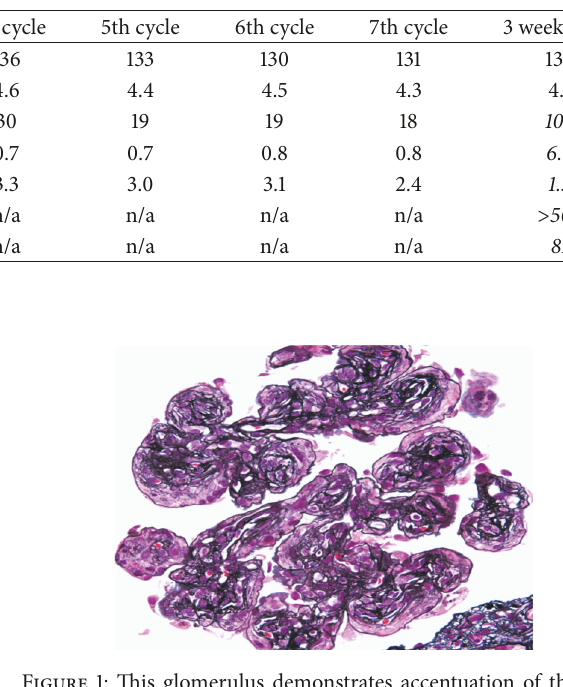
Figure 1: This glomerulus demonstrates accentuation of the lob- ular architecture with associated endocapillary hypercellularity and duplication of the glomerular basement membranes (Jones methenamine silver).